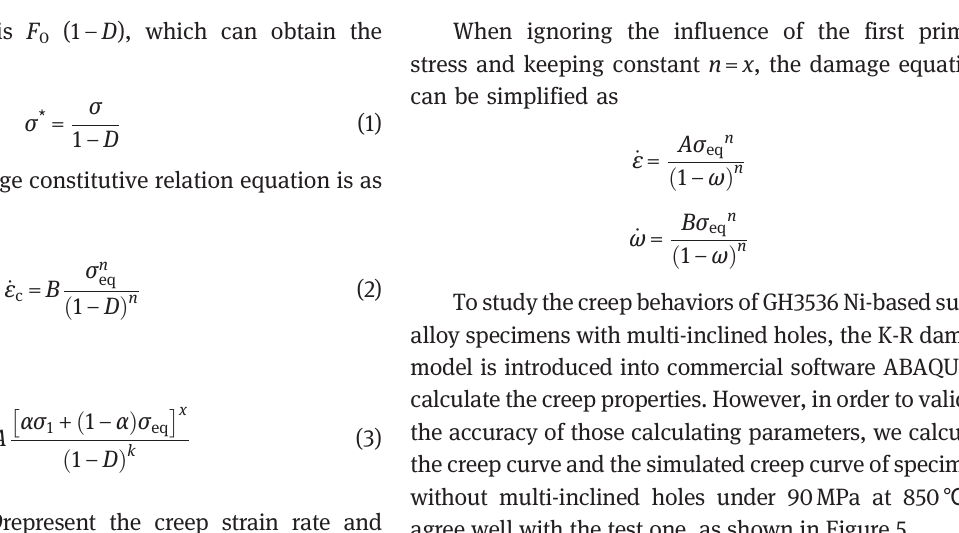
Figure 4: The creep curves of GH3536 plate specimens: (a) specimens with multi-inclined holes by laser drilling; (b) the creep strain versus stress of specimens with multi-inclined holes; and (c) the comparison of creep curves between specimens with multi-inclined holes and